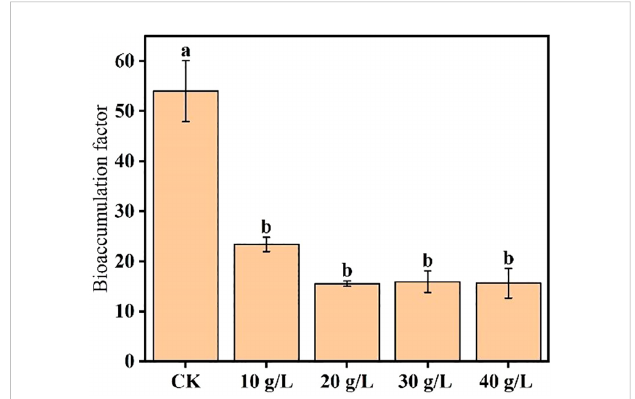
FIGURE 5 Effects of irrigation water salinity on the salt bioaccumulation factor of Suaeda salsa . Different lowercase letters indicate a signi fi cant difference ( p <